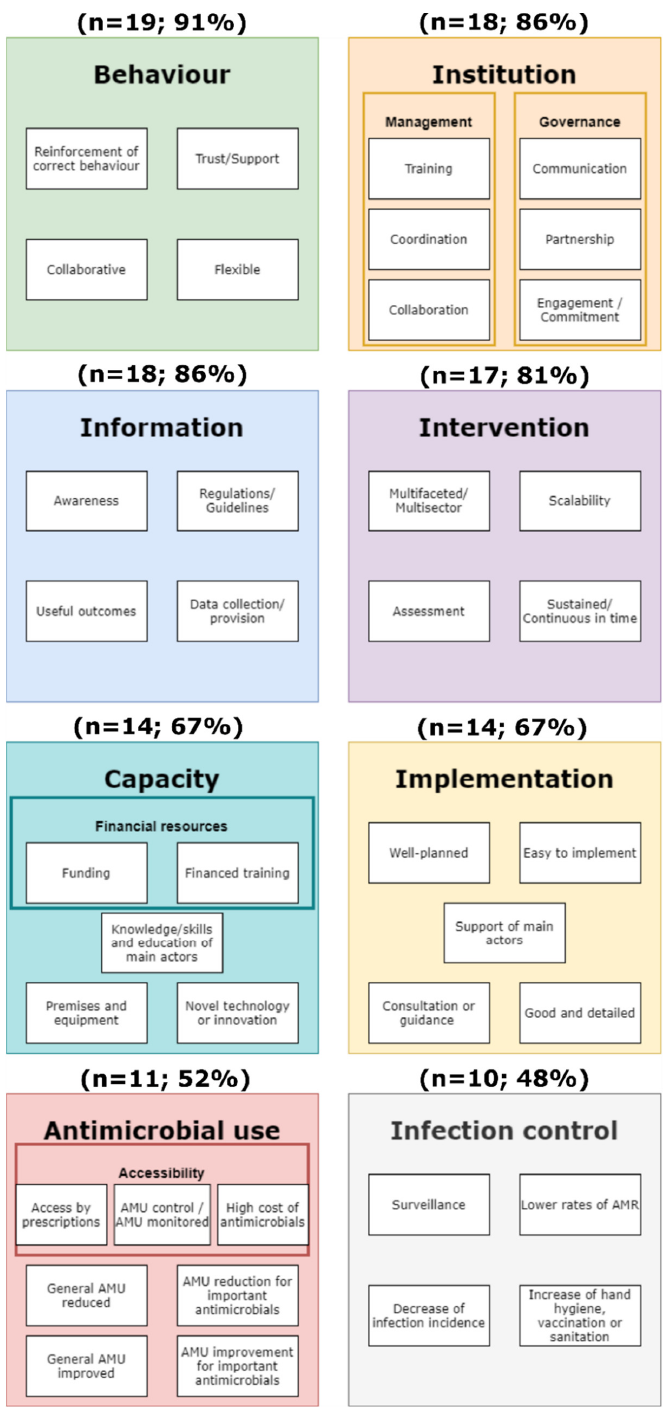
Figure 1. Key themes, categories, and sub-themes contributing to intervention success. Frequency and percentage of interventions reporting a particular theme are specified at the top of each block. Main blocks represent themes in different colour. Small white boxes represent sub-themes and, if present, categories are the coloured outline boxes grouping sub-themes. AMR = antimicrobial resistance; AMU = antimicrobial use.